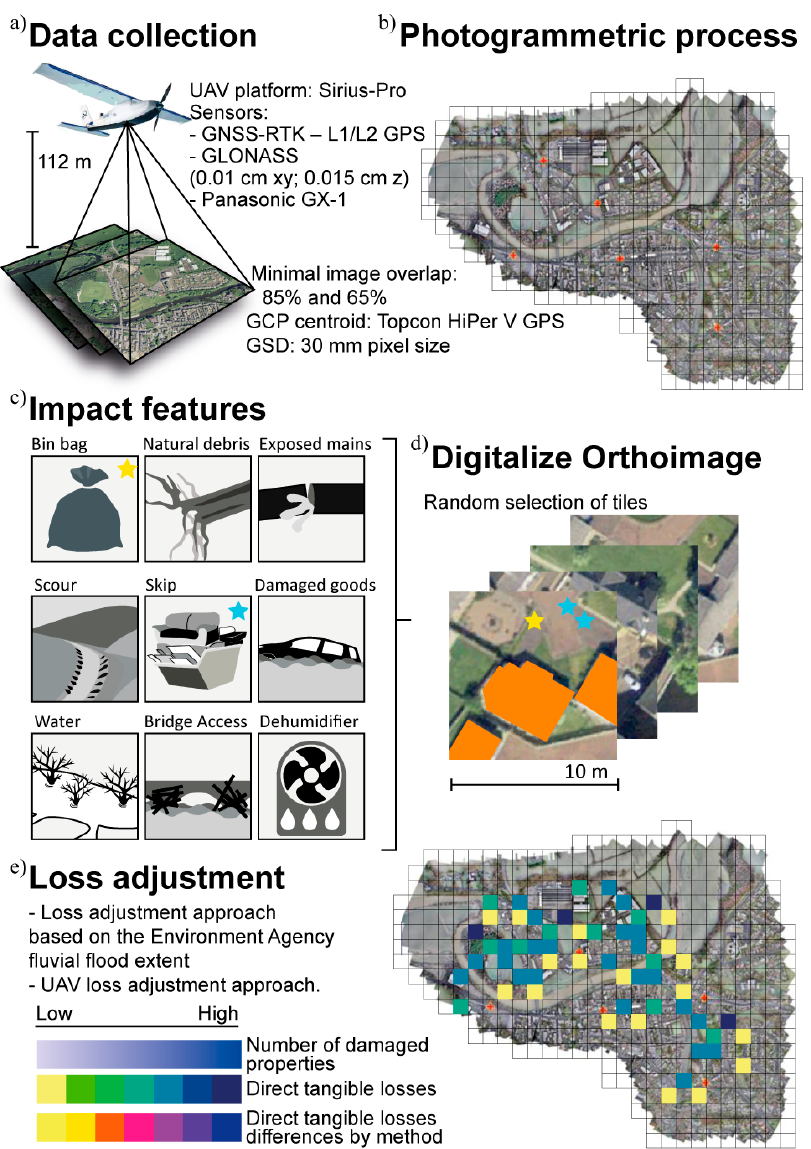
Figure 2. Workflow describing the key steps followed from data collection to loss adjustment estimates.